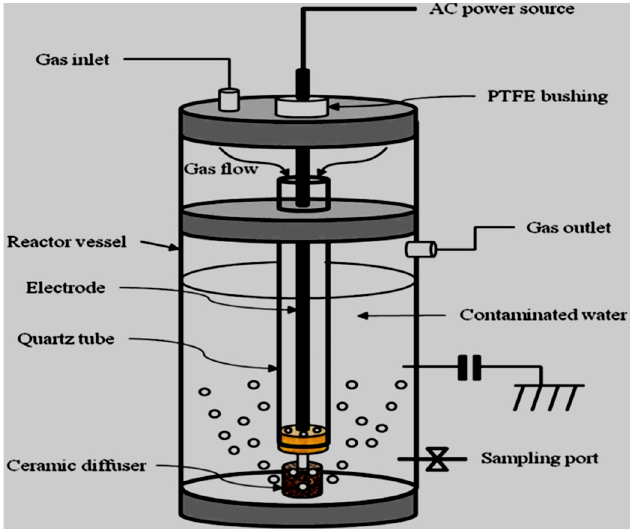
Figure 7. Experimental set up for the degradation of antibiotics [162].